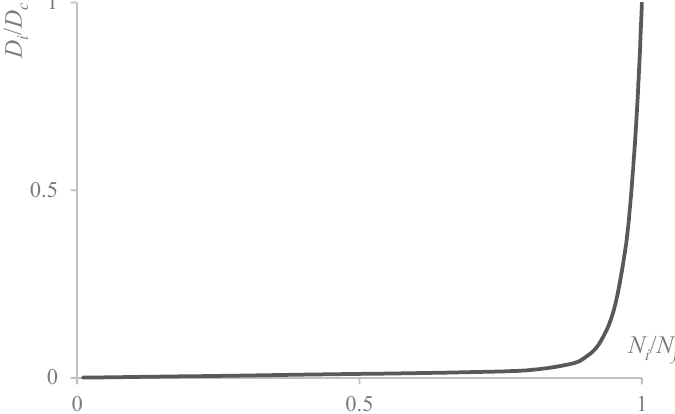
Figure 1. Relationship between damage variables and number of cycles.